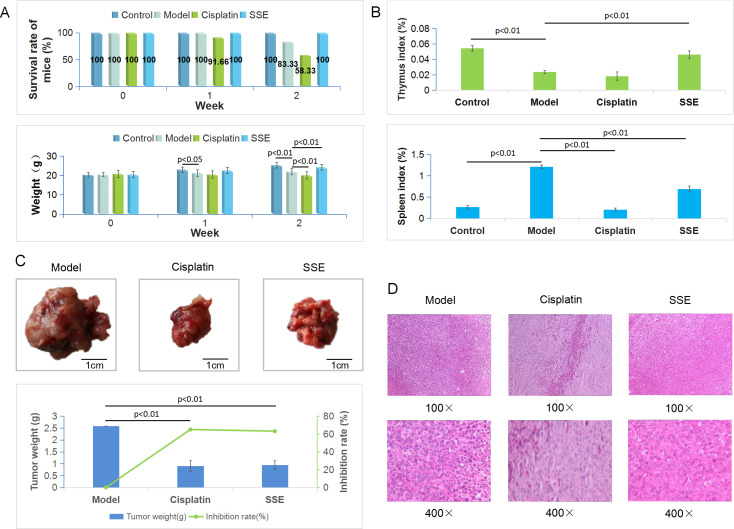
Anti-lung cancer activity of SSE in C57BL/6 mice.(A) Survival rates of mice and the changes of BW at different time points for the four groups; (B) Thymus and spleen indices of the four groups; (C) The macro views, tumor weights and inhibition rates of different groups; (D) H&E staining of tumor tissues in each group.